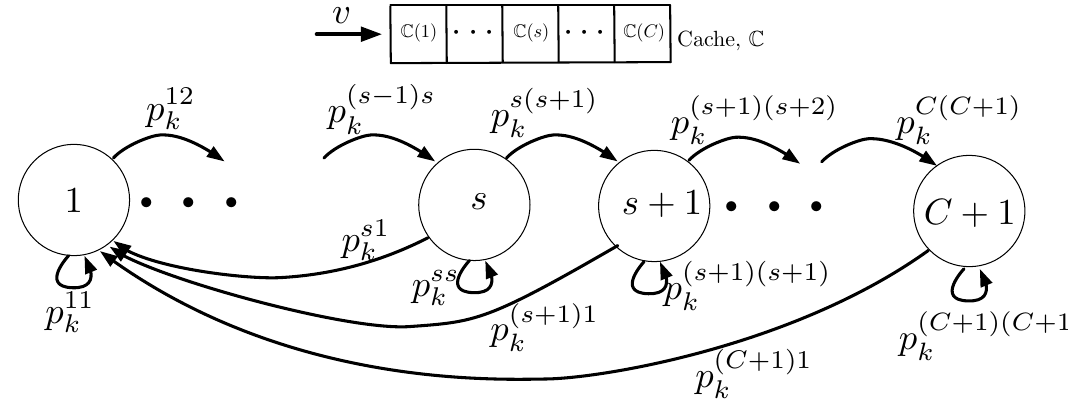
Figure 2. A state transition diagram of a video k in a cache with a length of C